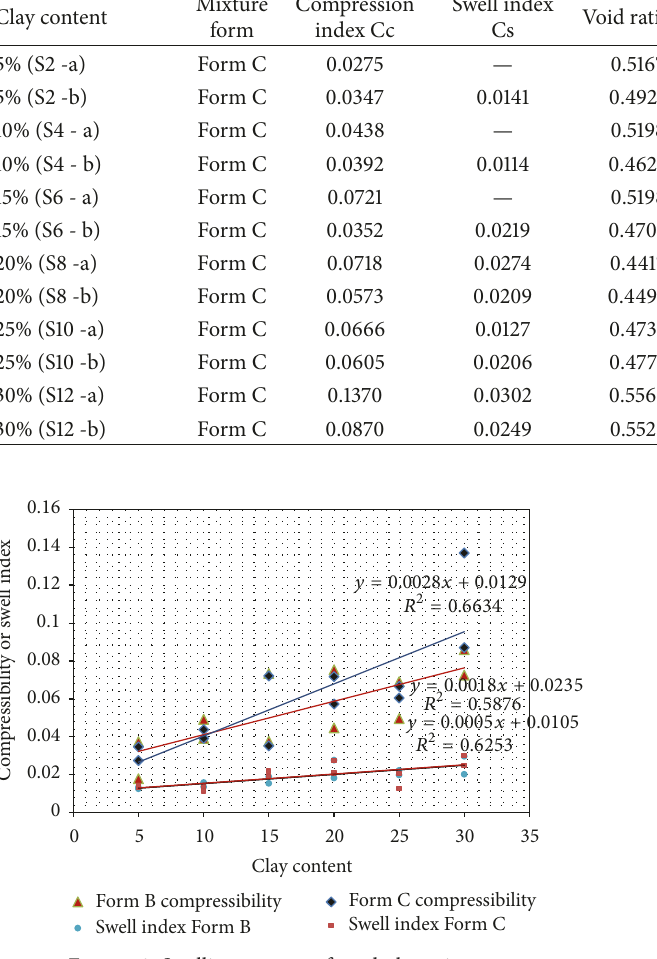
Figure 9: Swelling percent of sand-clay mixtures.